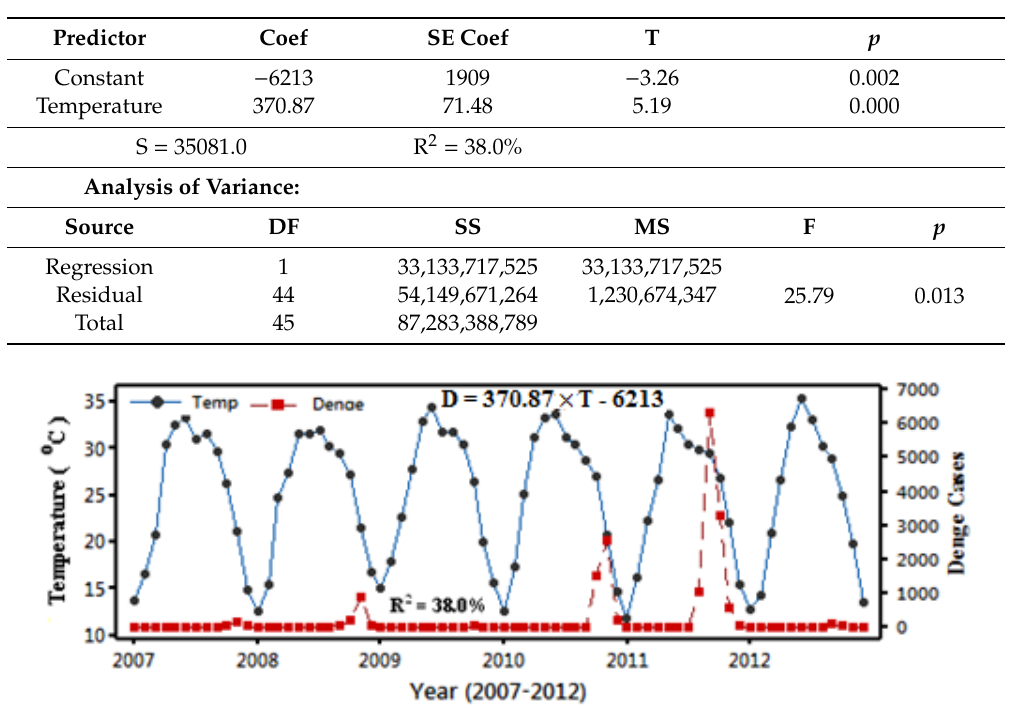
Table 4. Monthly ordinary linear regression analysis of dengue with temperature.